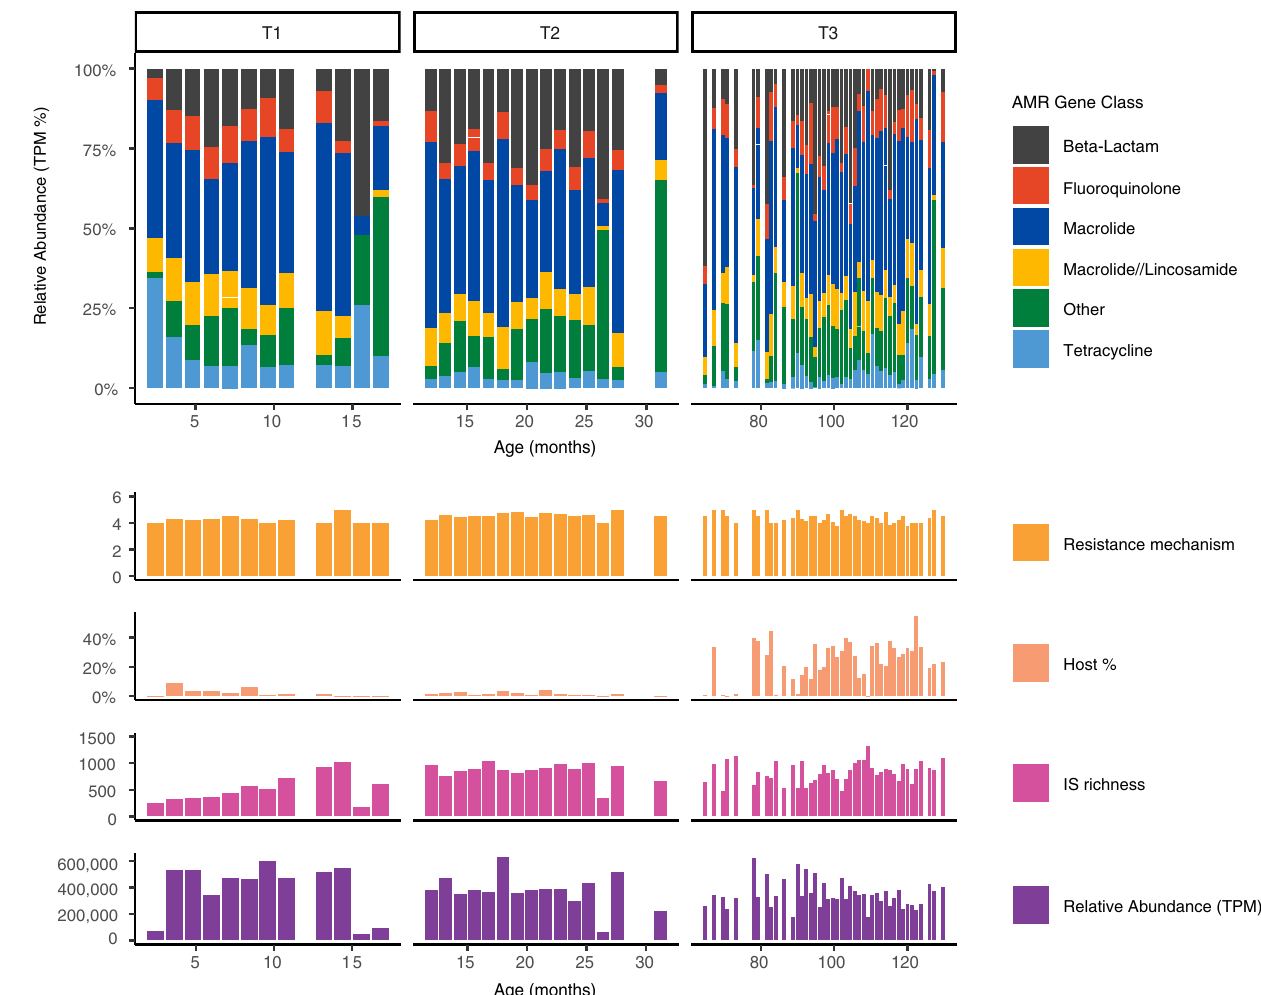
Fig. 1 | Overall composition of the paediatric oral resistome over the fi rst decade of life which is strati fi ed by age and sampling time point (T1, T2, and T3). The stacked bar chart shows the fi ve most abundant AMR gene class types, normalised by transcripts per million (TPM) which accounted for over